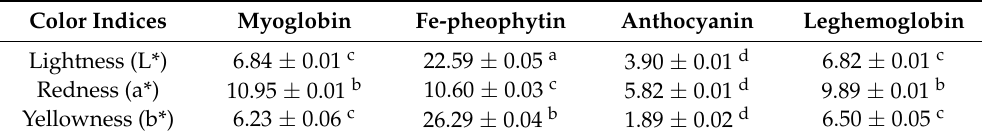
Table 2. Pigment samples color coordinates.